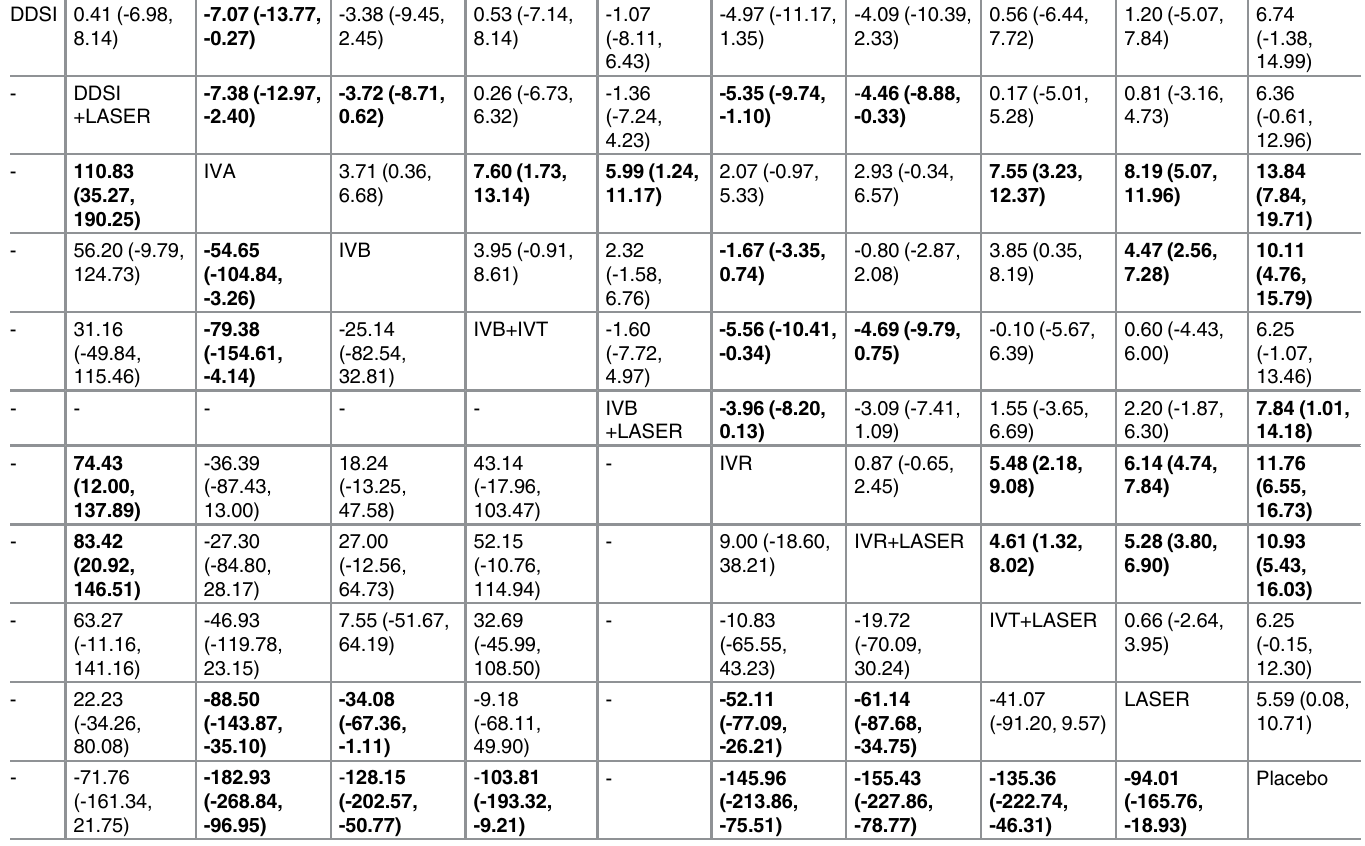
Table 3. Network meta-analysis results in BCVA (upper part) and CMT (lower part) at 12 months. DDSI 0.41 (-6.98, 8.14)